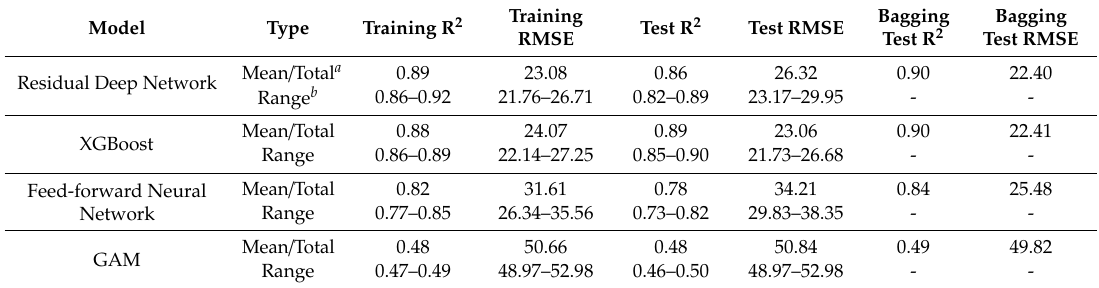
Feed-forward Neural Network